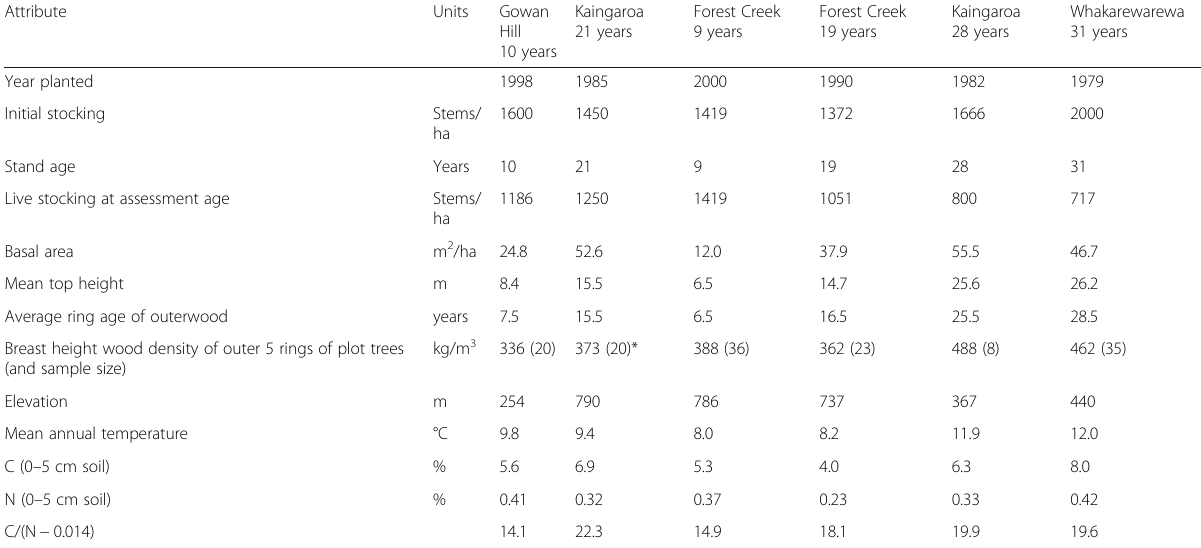
Table 3 Stand attributes, site characteristics, and wood density in Douglas-fir stands used to develop sub-model 3